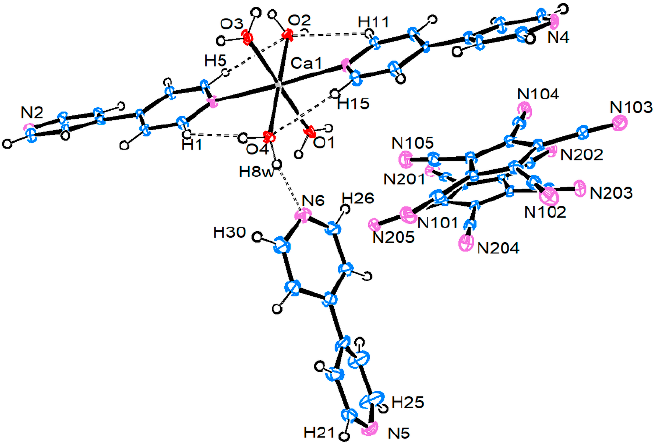
Figure 5. The asymmetric unit of compound 2 . Thermal ellipsoids at the 30% probability